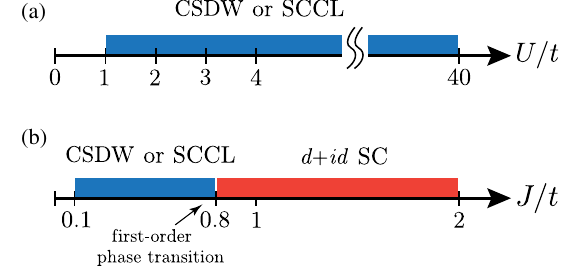
FIG. 3. The phase diagrams of the correlated electronic systems on the honeycomb lattice at 1 = 4 doping. (a) In the Hubbard model, the ground state is found to be either in a CSDW phase or in a SCCL phase over the majority of the parameter range 1 ≲ U=t < 40 . (b) In the t - J model, the CSDW phase or the SCCL phase is identified in the regime 0 . 1 < J=t < 0 . 80 ð 2 Þ , separated from the d þ id superconductor phase at larger J=t by a first-order phase